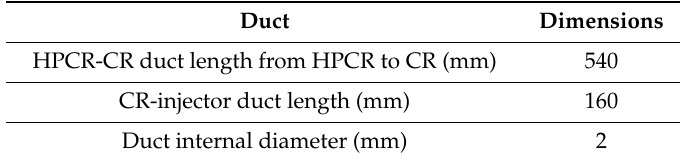
Table 2. High-pressure common rail (HPCR) injection system